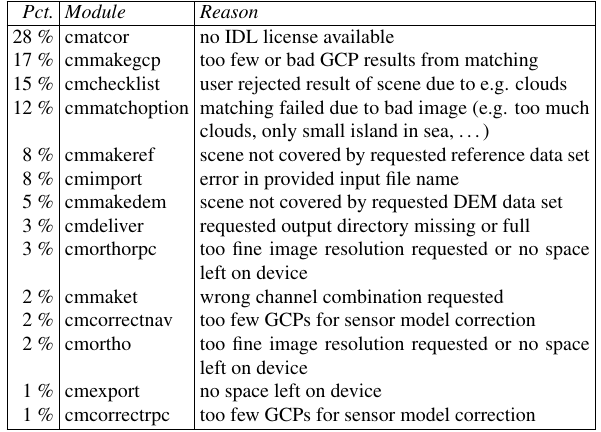
Table 4: Most frequent errors in automatic processing and their most likely reasons (more than one error may occur in processing a scene) Pct.